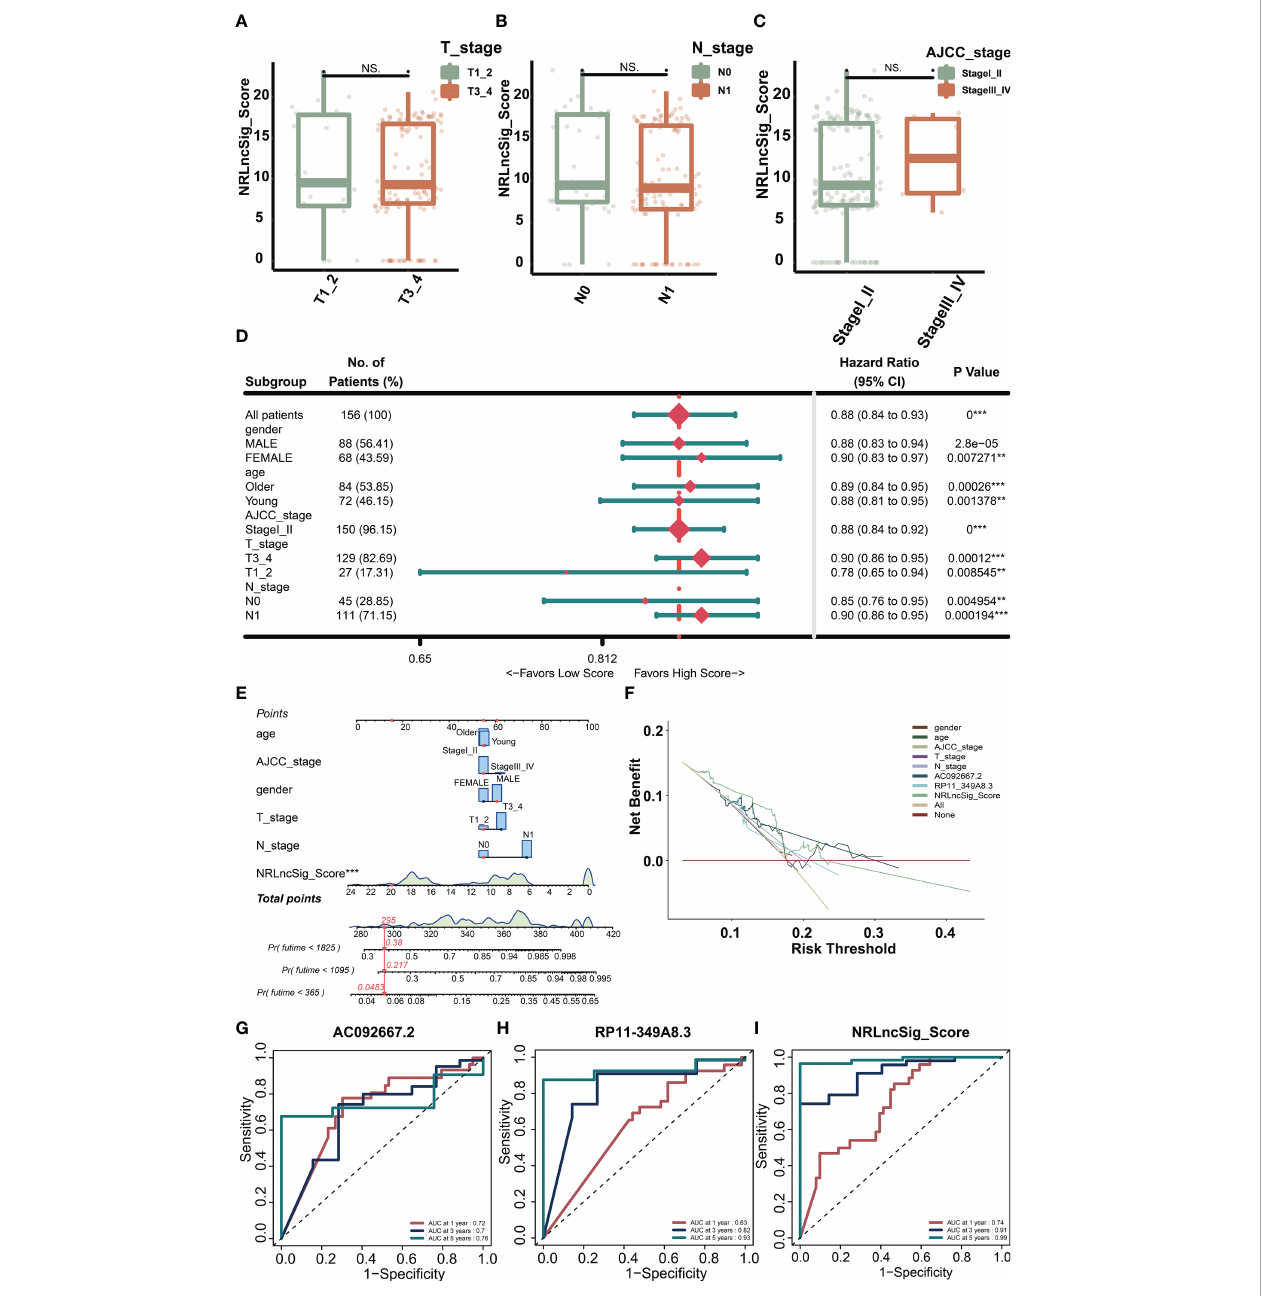
FIGURE 6 Validation of the NRS score model. (A) NRS Score in patients with different T stages. (B) NRS Score in patients with different N stages. (C) NRS Score in patients with different AJCC stages. (D) Clinical subgroup analysis of NRS Score. (E) Nomogram integrating clinicopathologic features and NRS Score. (F) The DCA curve of NRS Score with clinicopathologic features. (G – I) The time-dependent ROC curve of RP11-349A8.3, AC092667.2 and NRS Score. **p<0.01, ***p<0.001, NS indicates no signi fi cant